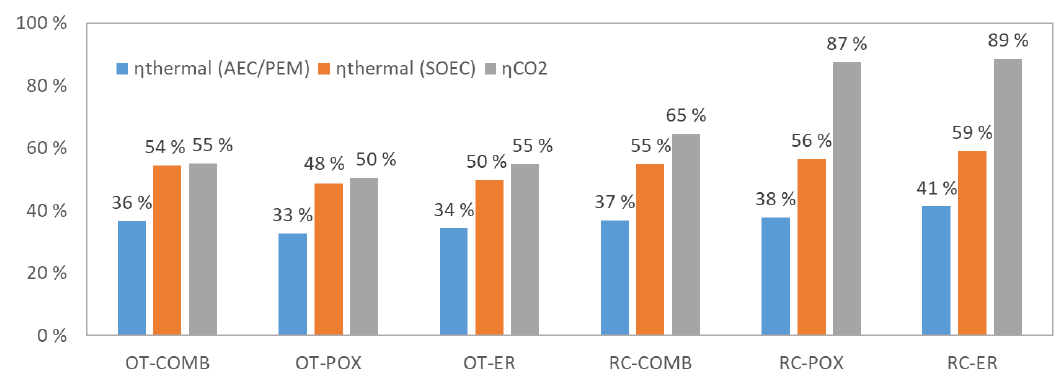
Figure 5. Simulated η thermal and η CO 2 for the examined process configurations when syngas preparation step operated at 900 °C. The η thermal is calculated separately using two different assumptions on the electrolyzer technology: low temperature electrolyzer (alkaline electrolyzers: AEC/proton exchange membrane: PEM) operating with water at 60% (LHV) net system efficiency, and high temperature electrolyzer (solid-oxide electrolysis cells: SOEC) operating with steam at 90% (LHV) net system efficiency.